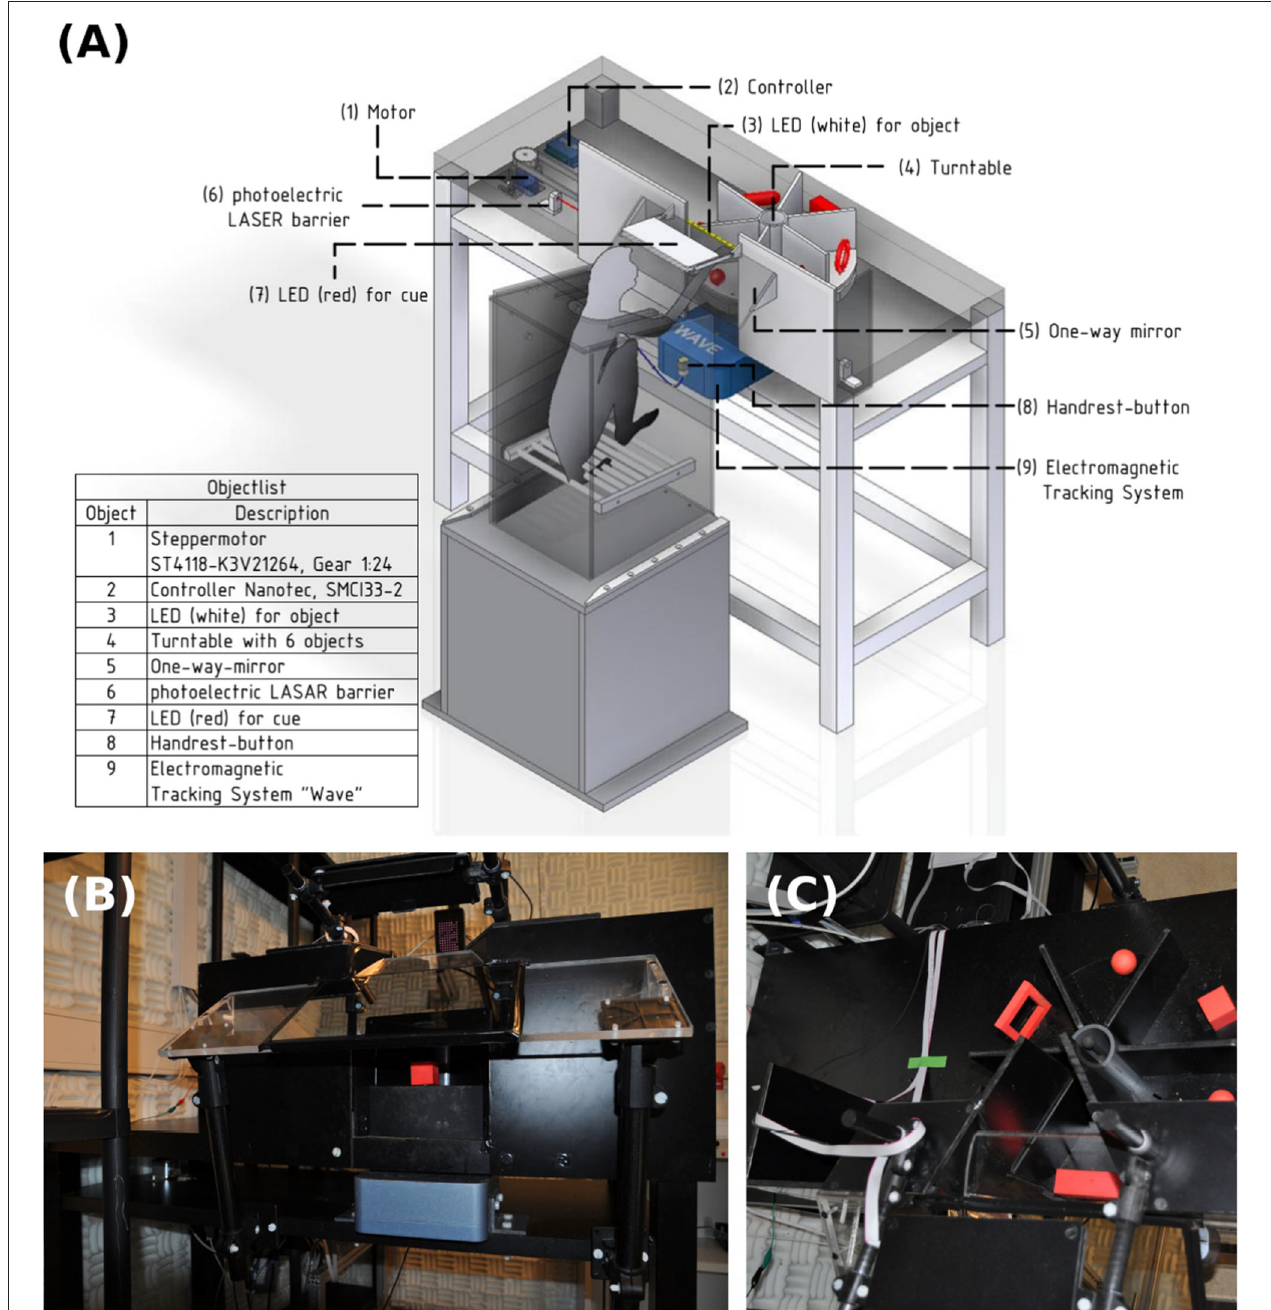
FIGURE 2 | Overview over the experimental setup. (A) Monkey sitting in a primate chair on top of a plastic box. On the table an object plate (4) with six red objects that can be rotated by a motor (1) and controller (2) positioned underneath the table. The animal can only see and interact with one object at a time. A strip of white LED lights (3) is placed above the object for illumination. A photo-electric Laser barrier (6) is placed below the turntable and above the object counterweights, to detect the lifting of an object. A one-way mirror (5) is placed between the monkey and the table, which projects, from the animal’s perspective, a red cue LED (7) onto the front object. A handrest button in front of the primate chair sets a consistent start position of the monkey’s hand and an electromagnetic field generator of the hand tracking system is placed below the object plate to track the monkey’s hand movements with a data glove (not shown). (B) Frontal view of the table. (C) Top view with turntable in the